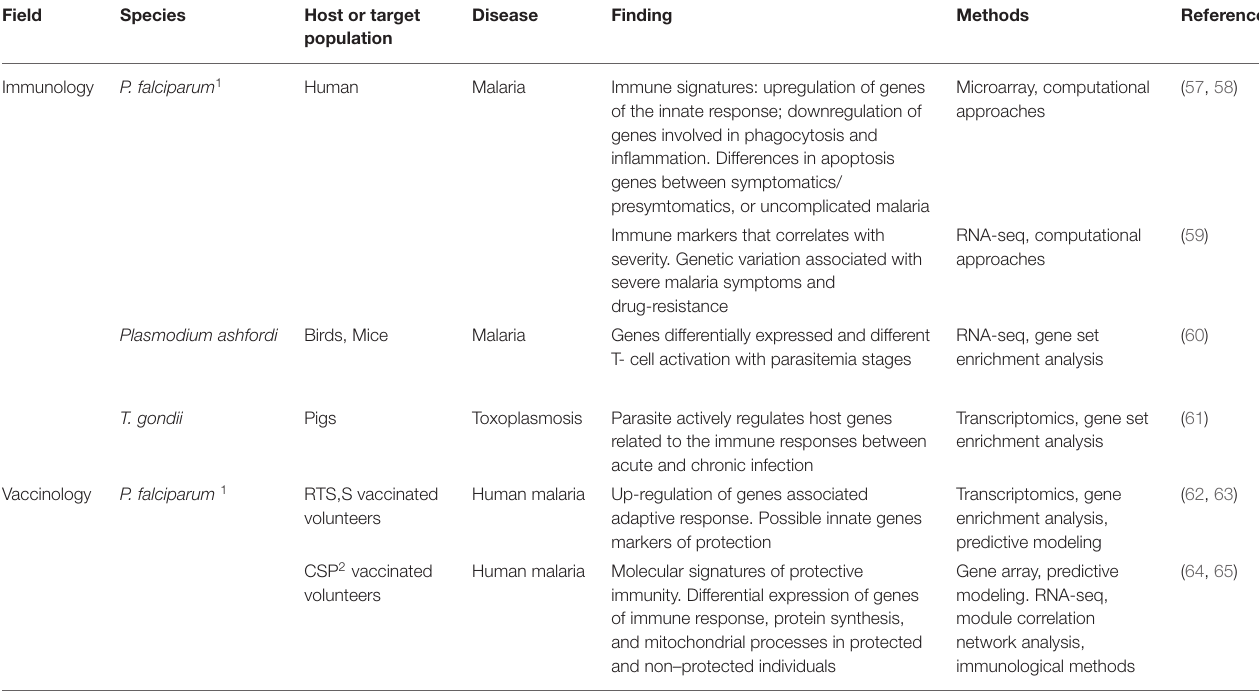
TABLE 1 | Systems biology approaches in the field of vaccinology and immunology applied to P. falciparum and T. gondii